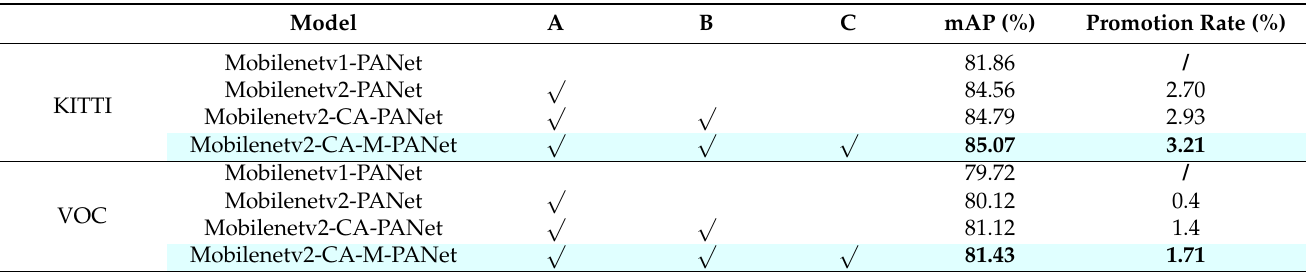
Table 3. Ablation